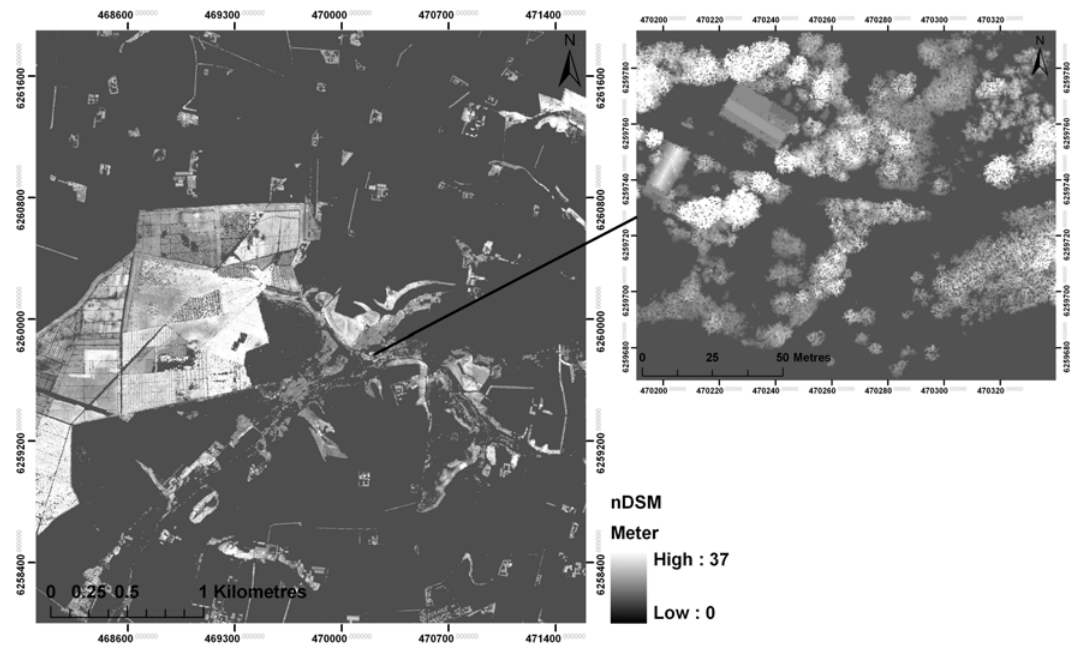
Figure 4. nDSM of the study area with a zoomed-in extract showing shrubs, trees and two